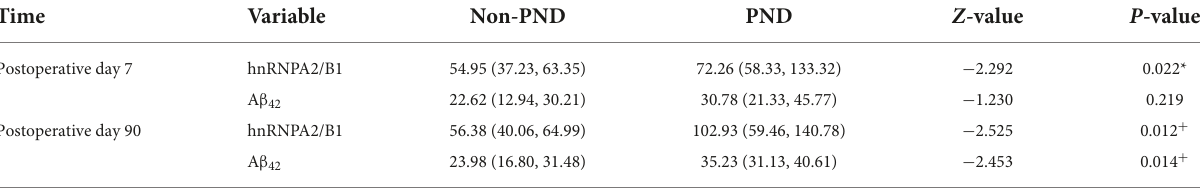
TABLE 3 Plasma hnRNPA2/B1 and A β 42 levels for patients with/without PND [pg/mL, M (Q1, Q3)].